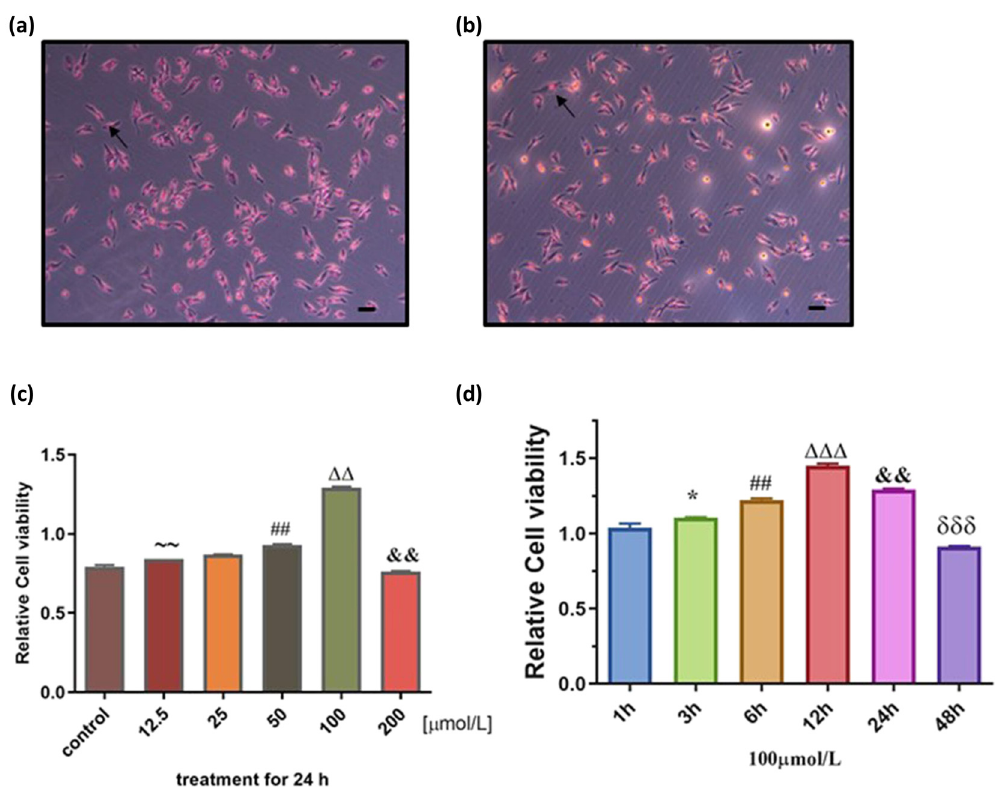
Figure 3: The cell proliferation of di ff erent concentrations of P - A acted on HUVEC at di ff erent time. ( a ) Representative images of HUVECs. ( b ) Representative images of ox - LDL - induced HUVECs. After the HUVECs were induced by 80 μ g/mL ox - LDL for 24 h, the cells had been damaged. ( c ) The cell proliferation activity increased with time in a concentration - dependent manner in 0 – 24 h. ∼∼ P < 0.01 vs control; ## P < 0.05 vs 25 μ mol/L; ΔΔ P < 0.01 vs 50 μ mol/L; && P < 0.01 vs 100 μ mol/L. ( d ) After 100 μ mol/L P - A acted on HUVEC 12 h, the cell proliferation activity was the largest. * P < 0.05 vs 1 h; ## P < 0.05 vs 3 h; ΔΔΔ P < 0.001 vs 6 h; && P < 0.01 vs 12h; δδδ P < 0.001 vs 24h. ( Mean ± SD, n = 3 )